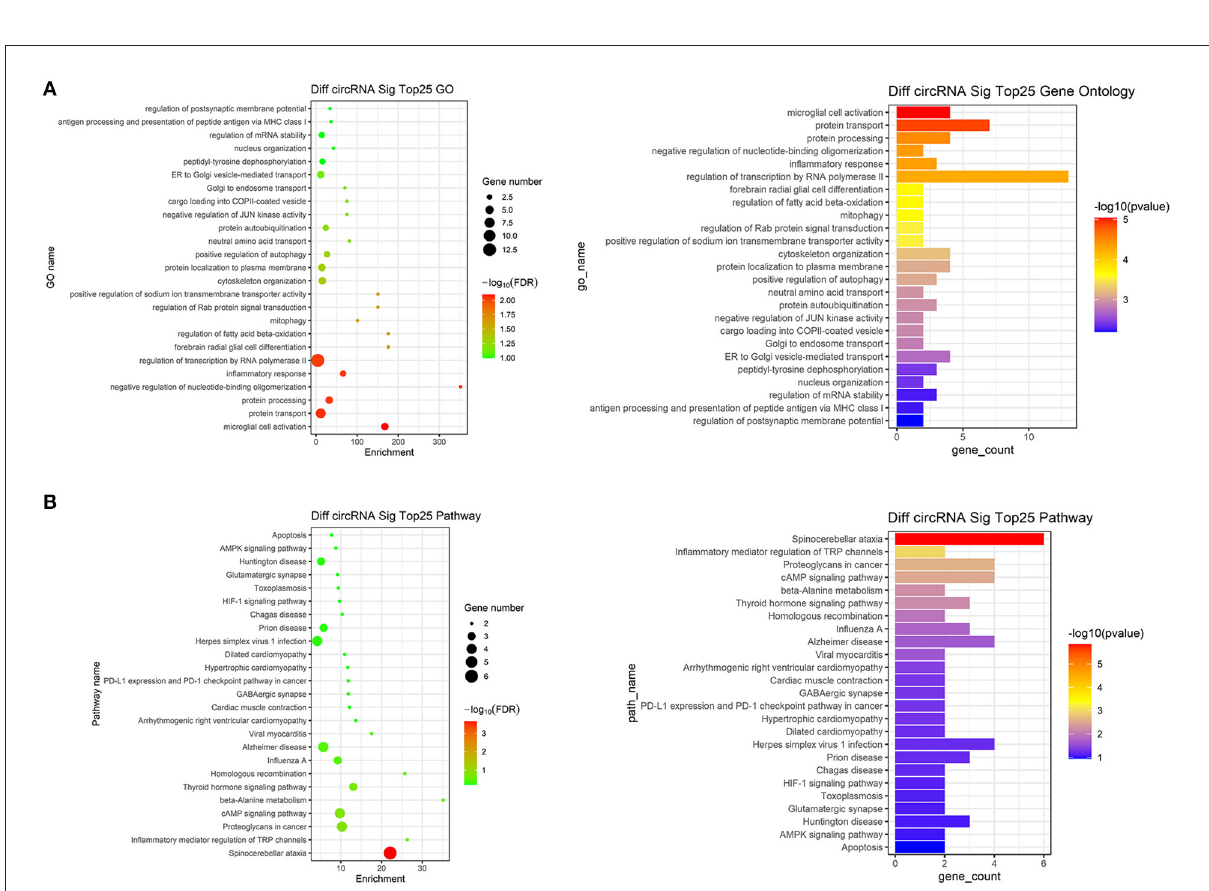
FIGURE2 Go analysis and KEGG pathway analysis. (A) The top 25 up-regulated and down-regulated biological processes related to differentially expressed circRNAs after TBI. (B) The top 25 up-regulated and down-regulated pathways related to differentially expressed circRNAs after